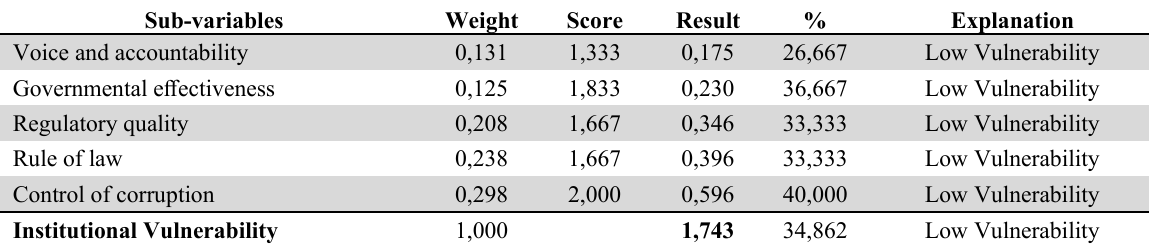
Vulnerability evaluation scores for power relationship of TNI-Polri in Institutional